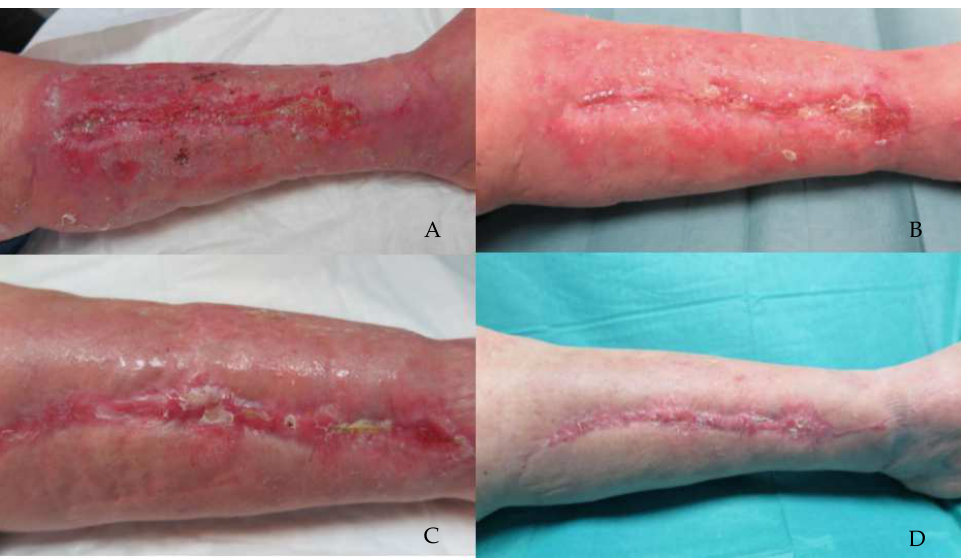
Figure 3. A 75-year-old female patient presented with a wound dehiscence localized on the medial aspect of the left leg. The patient was randomly assigned to the group treated with Connettivina ® Bio Plus cream and gauze. ( A ) Patient in V1. Wound bed is partially covered with fibrin, wound borders and perilesional skin are erythematous, and edema is observed. ( B ) Wound in V3, wound area sensibly reduced, wound bed exudate decreased considerably, although fibrin remained. Perilesional skin and wound borders improved overall. ( C ) Wound in V5. ( D ) V6, wound completely healed, and perilesional skin was a physiologic color.